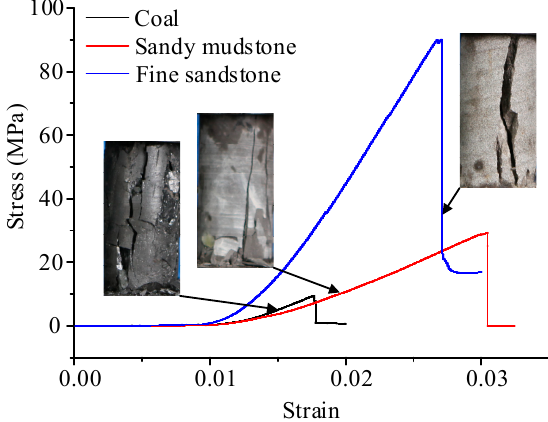
Figure 6. Stress–strain curve and failure morphology of the specimen under uniaxial compression.